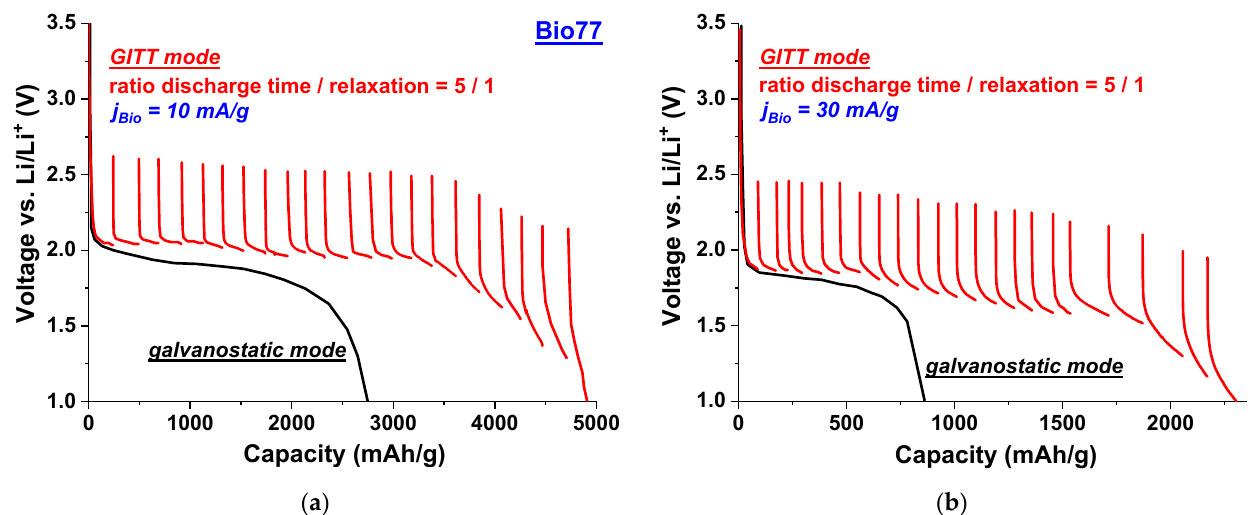
Figure 2. Discharge curves of ‘‘Biopolimer Peptide Batteries’’ (Bio77) obtained in the mode of galvanostatic intermittent titration with discharge current densities of 10 ( a ) and 30 ( b ) mA/g.